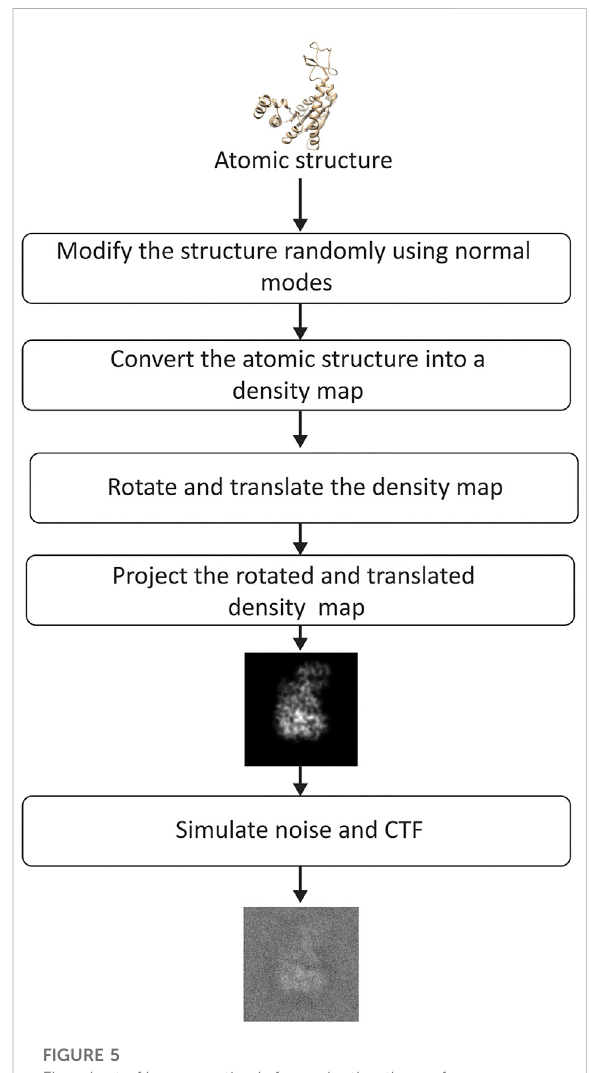
FIGURE 5 Flowchart of image synthesis for evaluating the performance of DeepHEMNMA. See the text for the details on the synthesis of random normal-mode amplitudes, angles, and